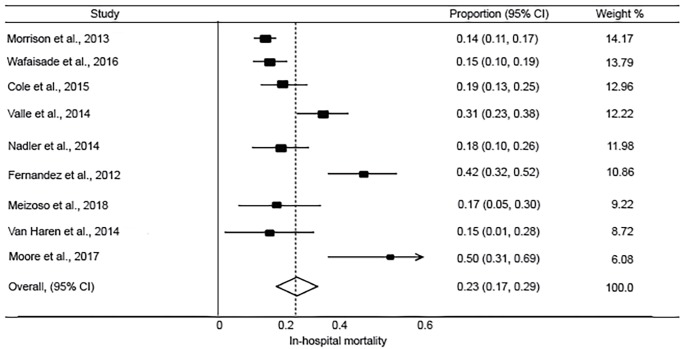
Forest plot of the incidence of in-hospital mortality after tranexamic acid use in injured adults.CI, confidence interval.Chi-square=53.35 p<.0001; I2=85.0%.